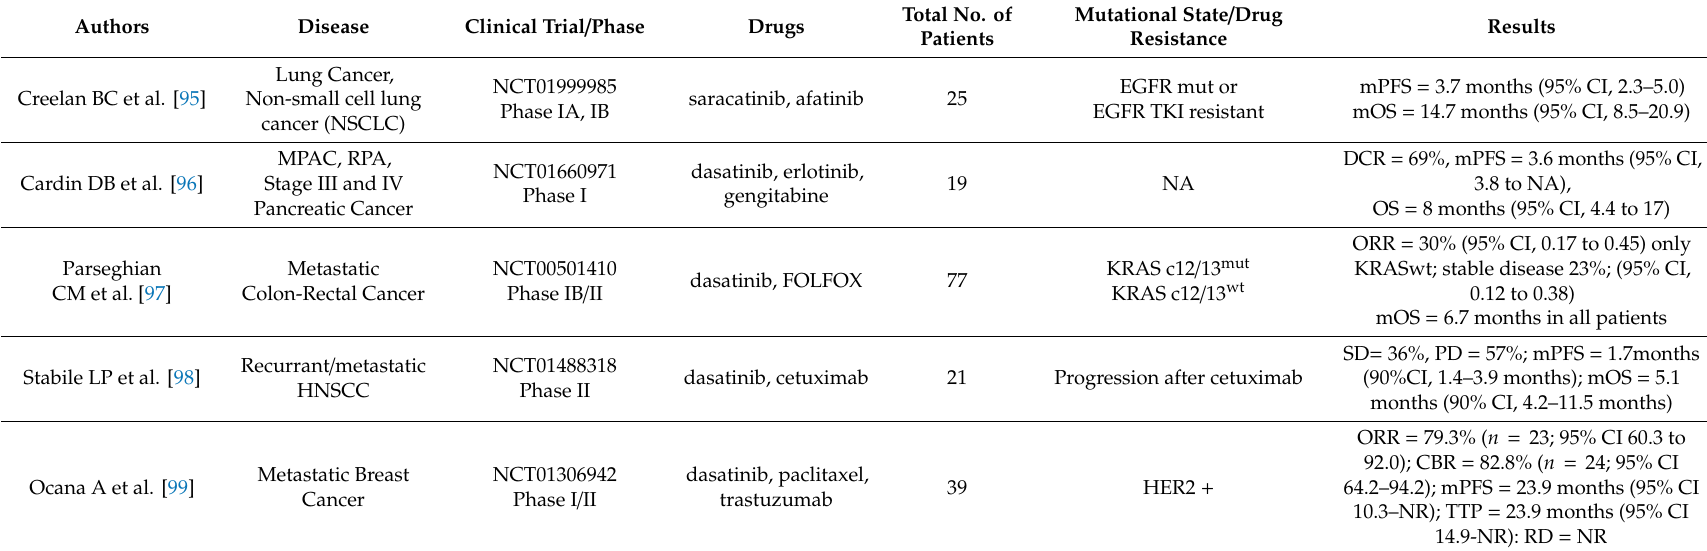
Table 2. Clinical trials combining EGFR inhibitors and c-Src kinase